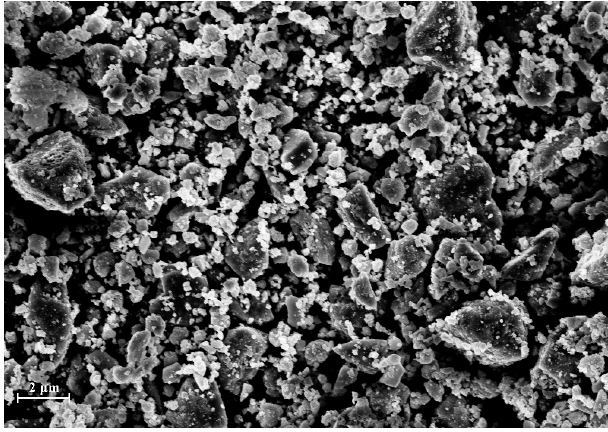
Figure 4. SEM spectra of BiYTi 2 O 7 .